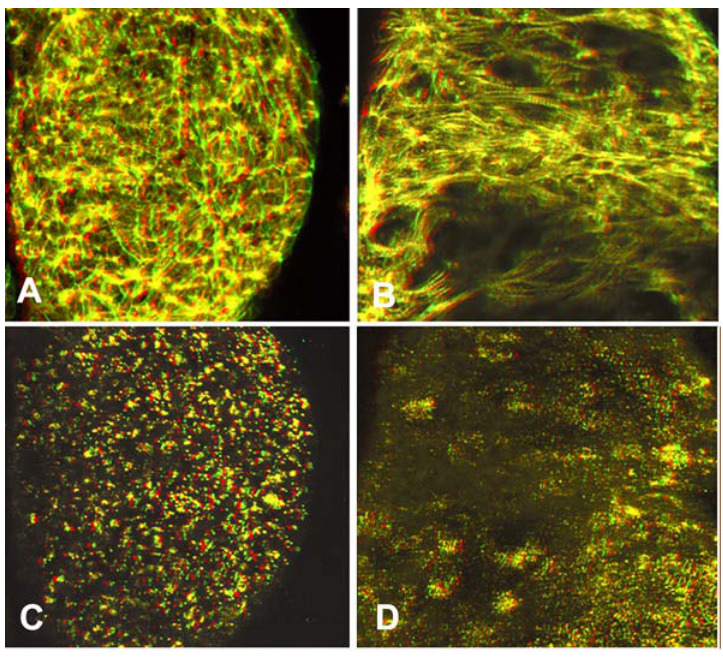
FIGURE 3 . Three-dimensional confocal rendering of organization of F-actin (red, panels 3A, 3B) and flectin (green, panels 3C,3D) at HH stage 9 (Figs. 3A and C) and stage 11 chick heart (Figs. 3B and 3D). Readers will need red and green color glasses to visualize the 3D information. Between stages 9 and 11, F-actin in the myocardial layer near the cardiac jelly becomes circumferentially arranged around the heart tube during looping. More flectin is present in the left side of the avian heart tube in a punctate manner in relation to the myocardial layer and within the adjacent cardiac